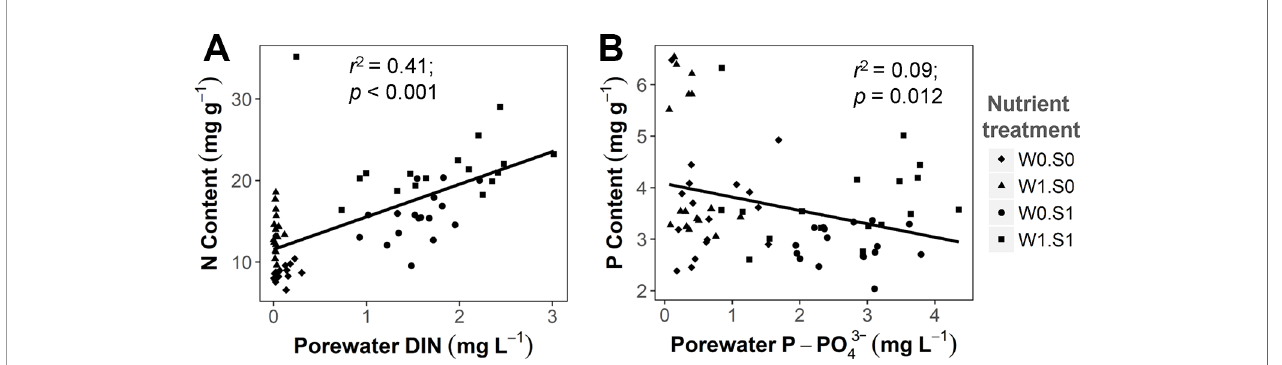
FIGURE 5 | The relationship between sediment porewater nutrient concentrations and plant nutrient contents. (A) porewater DIN concentration and plant N content, DIN indicates total dissolved inorganic nitrogen (including N from NH 4+ , NO 2 − , and NO 3 − ). (B) porewater P-PO 43 − concentration and plant P content. Linear regression test results are shown in the fi gures. See caption of Figure 2 for an explanation of the abbreviations of the nutrient treatments.